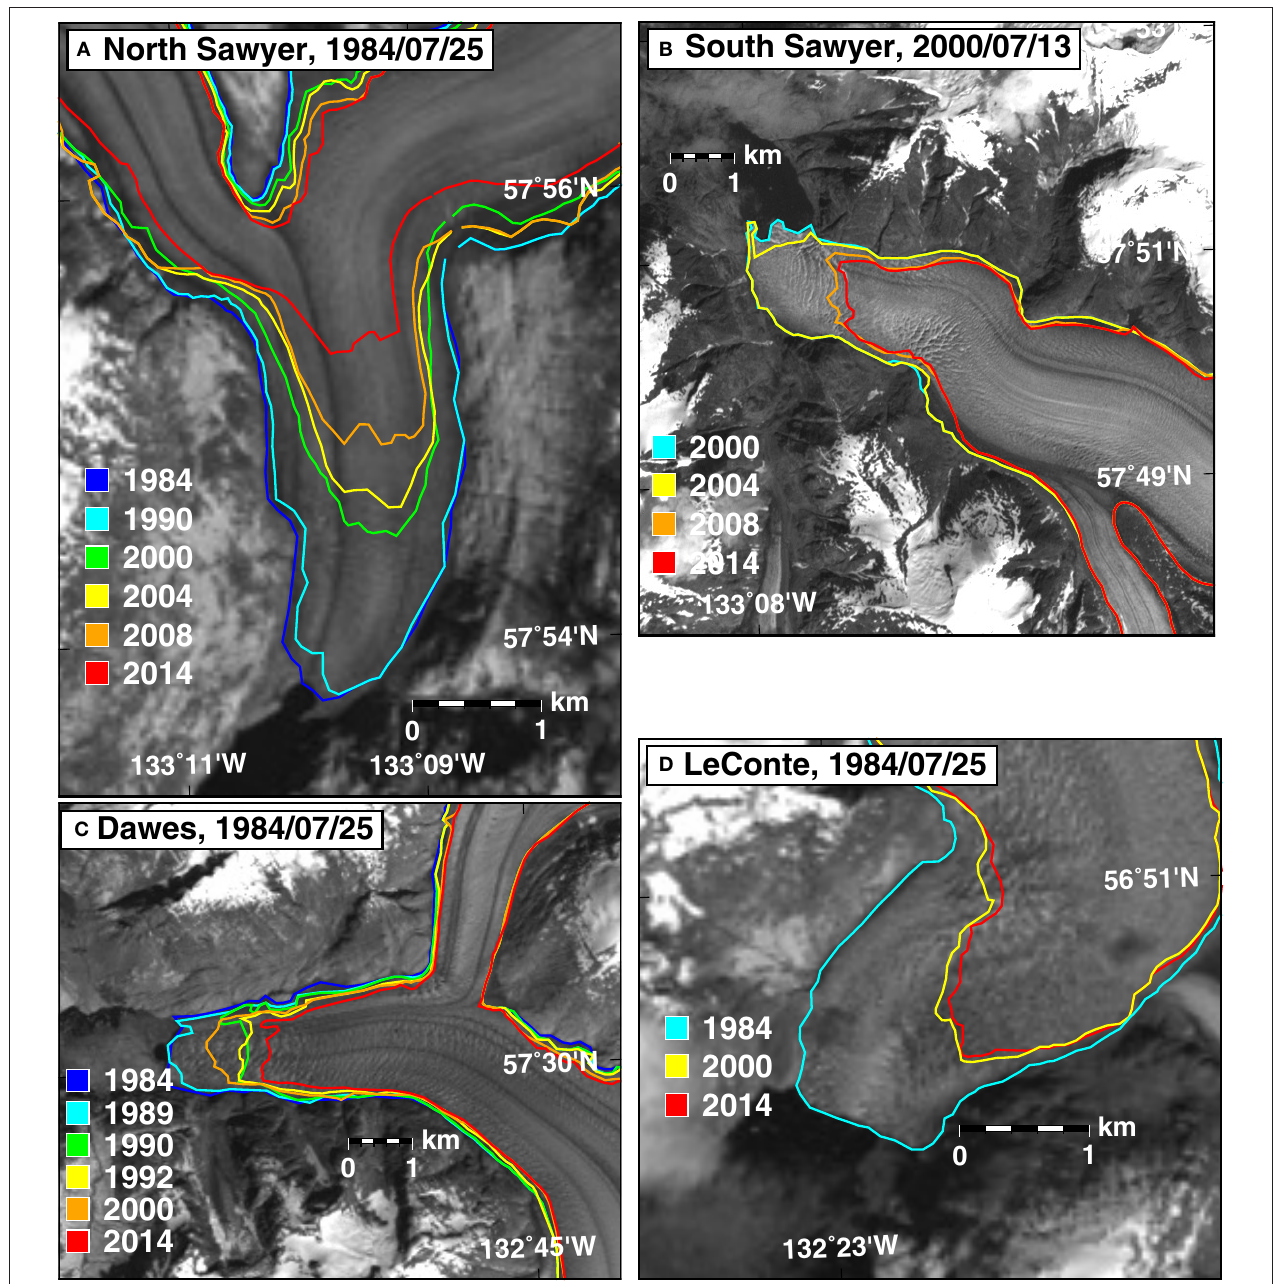
FIGURE 5 | Selected front positions between 1984 and 2014 for the four major marine-terminating glaciers on the Stikine Icefield. Panels (A–D) show North Sawyer, South Sawyer, Dawes, and LeConte, respectively. The date of the Landsat background image is given in the panel label. “Cooler” colors are earlier front positions, “warmer” colors are more recent front